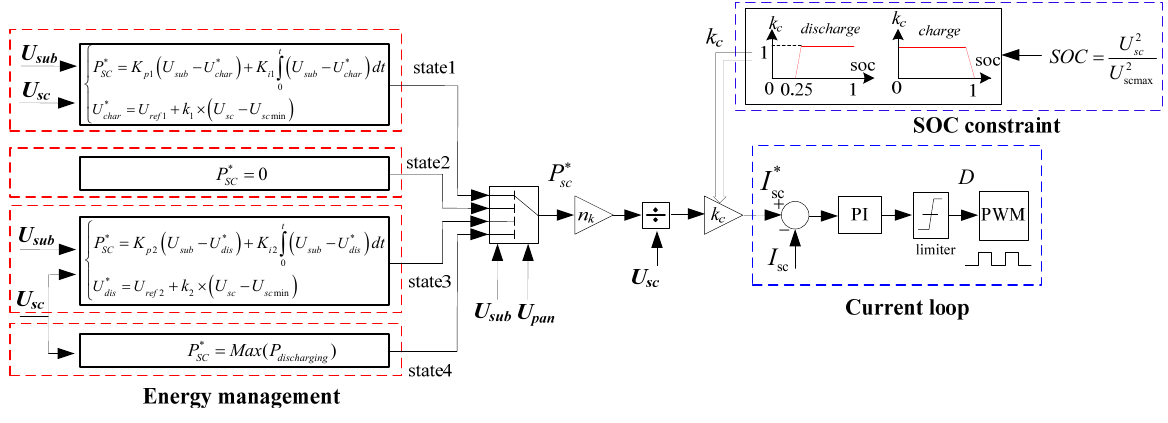
Figure 9. The improved energy management strategy of stationary ESSes.